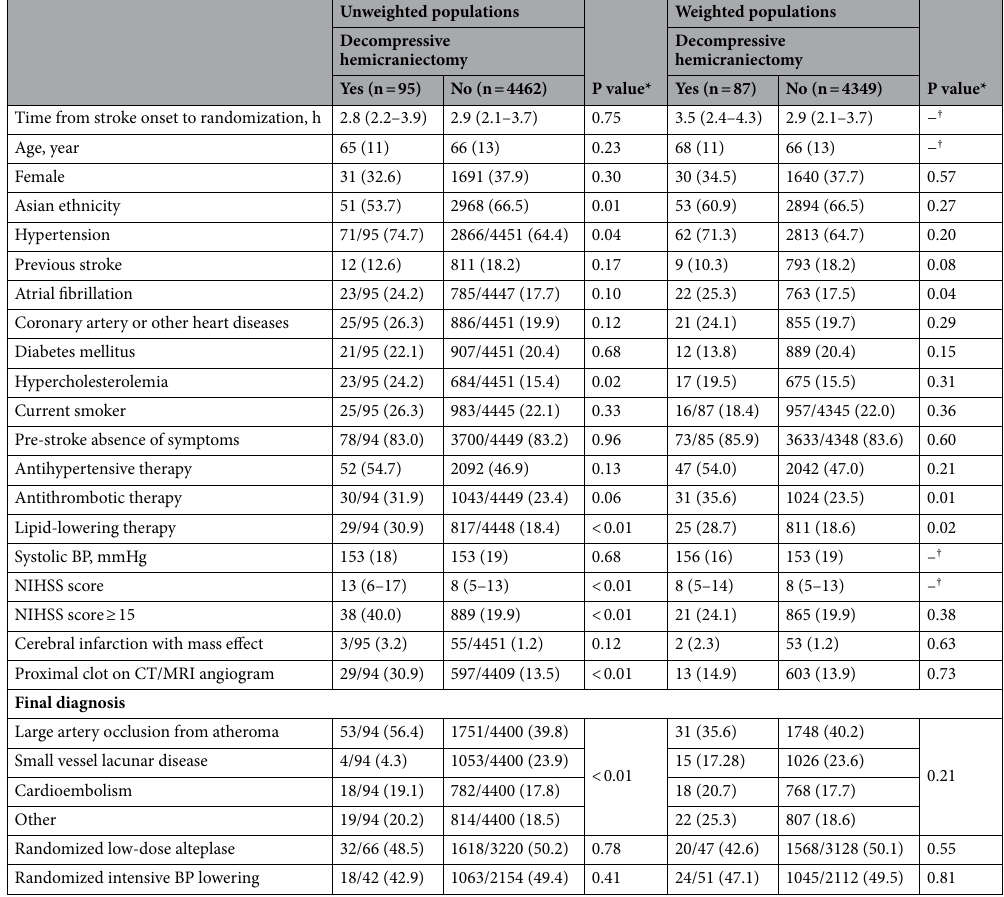
Table 1. Baseline characteristics in relation to decompressive hemicraniectomy for acute ischemic stroke, according to the use of inverse probability of treatment weighting. Data are n (%), mean (SD), or median (IQR). BP blood pressure, CT computed tomography, MRI magnetic resonance imaging, NIHSS National Institute of Health Stroke Scale. *P values based on χ 2 test, Fisher’s exact test, or Wilcoxon test. † Not applicable for continuous variables in weighted